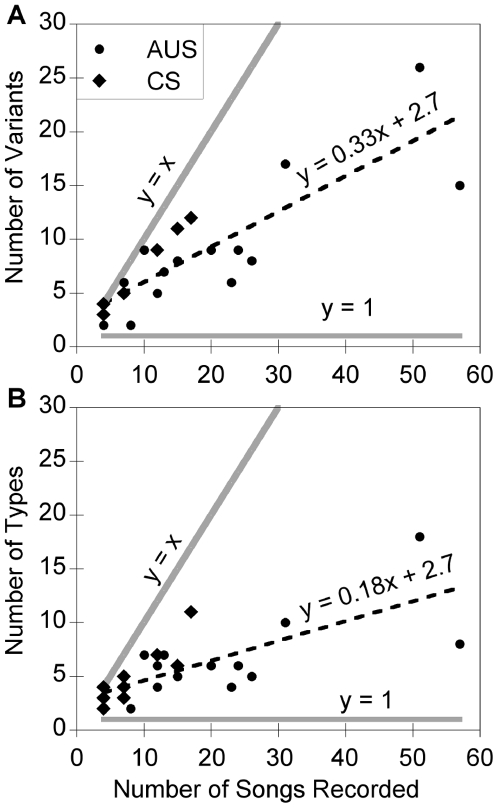
Song variants and song types.The number of song variants (with repetitions, A) and song types (without repetitions, B) as a function of the number of songs recorded for each bat. For each graph a line is shown for the case when every song recorded is unique (y = x) and when every song recorded is the same (y = 1). Only bats with a minimum of four recorded songs were included (N = 26 bats).